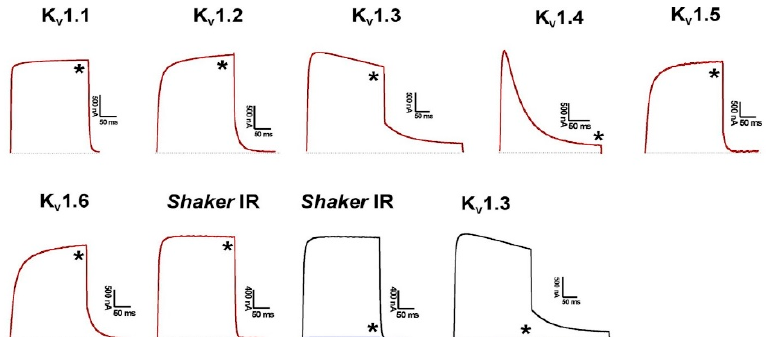
Figure 4. Differential effects of 1 µ M toxin on Kv isoforms expressed in Xenopus laevis oocytes. The dotted line indicates the zero-current level. The black line indicates the current in control conditions, the red line indicates the steady-state current in the presence of 1 µ M Bot33, the blue line indicates the steady-state current in the presence of 1 µ M ChTx, while the * indicates the selected trace after application of toxin.